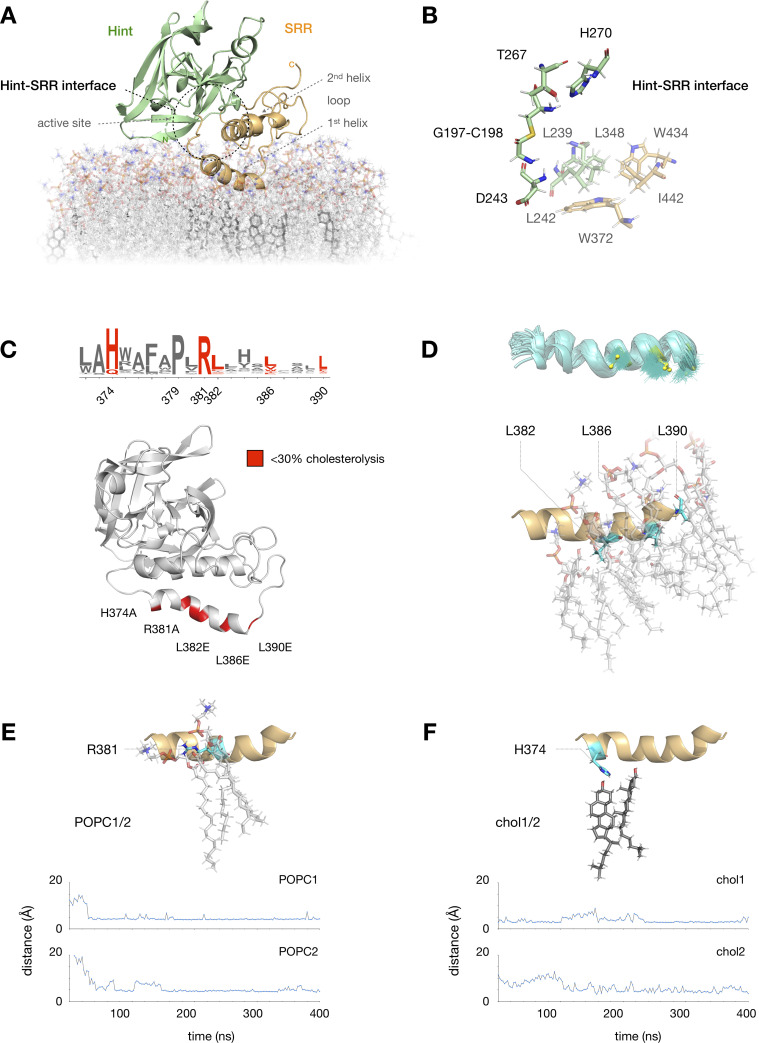
MD analysis highlights hydrophobic SRR interactions.(A) Equilibrated MD model of the apo hSHH Hog domain in a phosphatidylcholine (POPC) bilayer containing ~20% cholesterol; the Hint-SRR interface is indicated by a dashed black circle. (B) Expansion of residues near the Hint fold active site (D243, T267, H270, and the G197-C198 thioester). Hydrophobic residues in the Hint fold (L239, L242, and L348) and the SRR (W372, W434, and I442) remain within 5 Å of each other during a 400 ns MD equilibration. (C) Summary of conserved residues in the 1st SRR helix (W372-L390) where mutation impairs hSHH cholesterolysis in cells (ref 17). (D) Three leucine residues in the 1st SRR helix (L382, L386, and L390) remain localized next to POPC tails during equilibration. Top: superimposed trajectories (teal) of L382, L386, and L390 side chains (yellow) over 400 ns. Bottom: 400 ns snapshot of the 1st SRR helix, showing L382, L386, and L390 (teal) interacting with POPC tails in the membrane. (E) Above: 400 ns snapshot of the interaction between R381 (teal) and two POPC molecules. Below: Plot showing equilibration of the distance between the R381 side chain and POPC headgroups to 3.9 ± 0.4 Å (POPC1) and 4.7 ± 1.8 Å (POC2) over 400 ns. (F) Above: 400 ns snapshot of the interaction between H374 (teal) and two cholesterol molecules. Below: Plot showing equilibration of the distances between the H374 side chain and two cholesterol C3-OH groups to 3.9 ± 0.4 Å (chol1) and 4.7 ± 1.8 Å (chol2) over 400 ns.